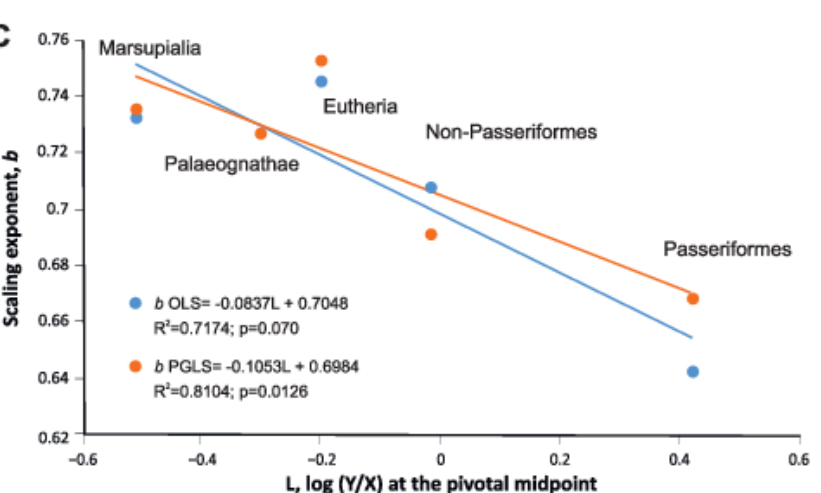
Figure 7. Dependence of scaling exponents on the allometric coefficients “ a ” (the level of metabolism) in five groups of endotherms: ( A ) “ a ” in mL O 2 /h per g. ( B ) “ a ” (ratio). The scaling exponents and the allometric coefficients were obtained by the ordinary least squares model (OLS—blue line) and phylogenetic generalized least squares model (PGLS—yellow line). ( C ) Dependences of the scaling exponents on the level of metabolism a measure of scaling elevation, L, which is log (BMR/m) at the pivotal midpoint of a log–log scaling relationship) in five groups of